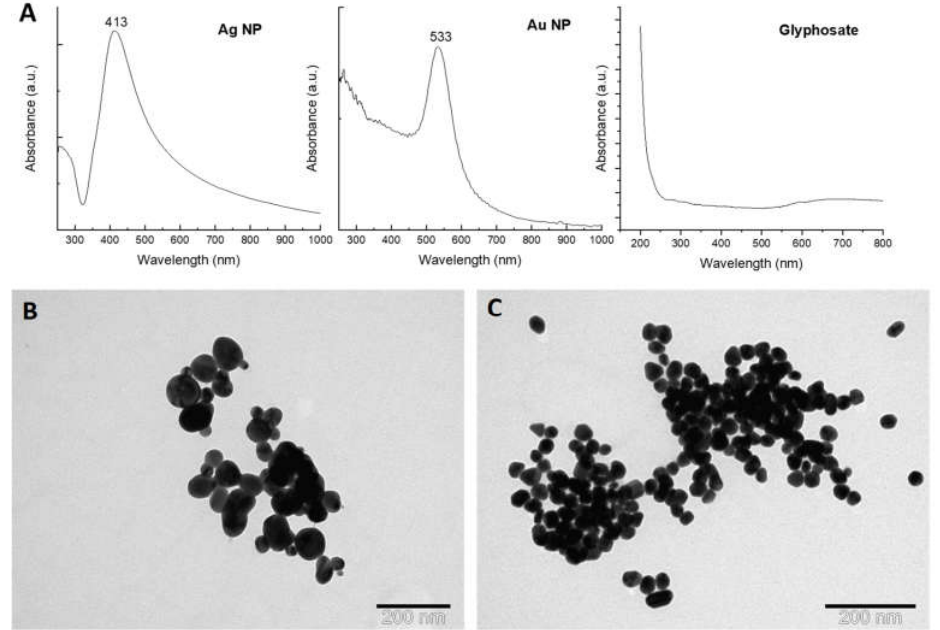
Figure 1. ( A ) UV–Vis spectra of synthesized nanoparticles and glyphosate solution (2.4 mM); TEM images of ( B ) Ag NPs and ( C ) Au NPs.